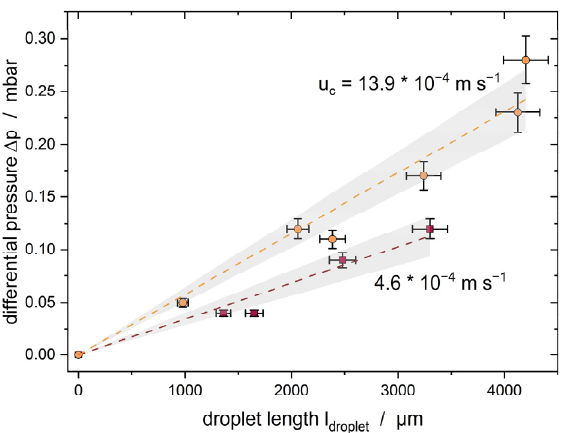
Figure 11. Experimental results of droplets moving along the microfluidic channel for two different velocities of the continuous phase u c . The grey areas represent the 95% confidence intervals of the linear fits.